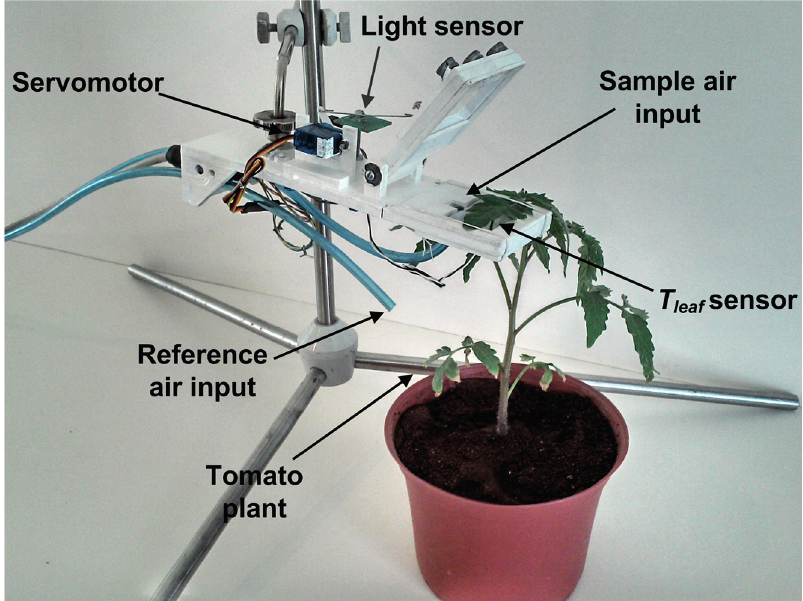
Figure 2. Leaf chamber and sensors